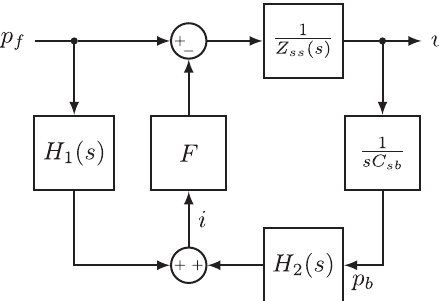
Figure 2. Block diagram of the mixed feedforward-feedback controlled absorber.